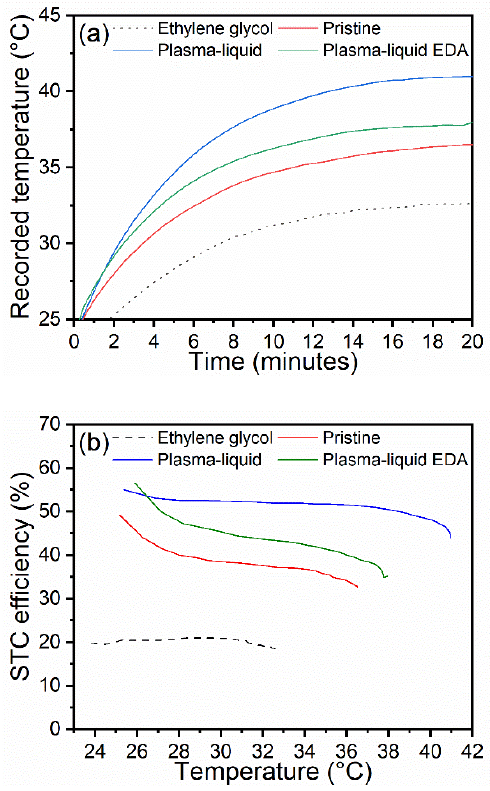
Figure 9. ( a ) Variation in temperature of the nanofluids and ethylene glycol over 20 min of exposure to simulated solar radiation, and ( b ) their resulting solar–thermal conversion efficiency after accounting for heat lost.